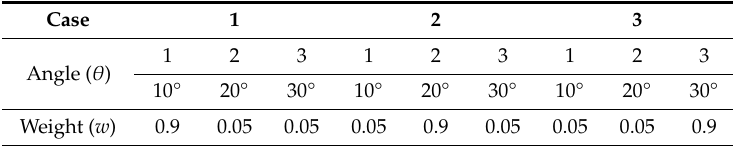
Table 2. Uphill angle weighting